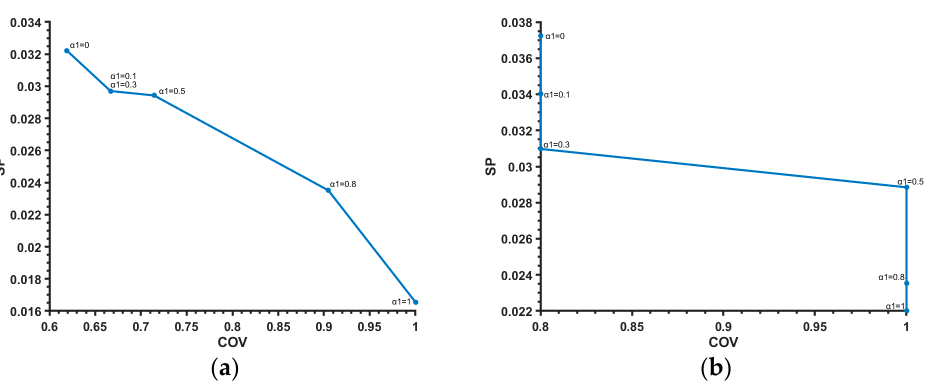
Figure 11. The curve of cov - sp values under different values of α . ( a ) The 0th cluster ( b ) The 1st cluster.